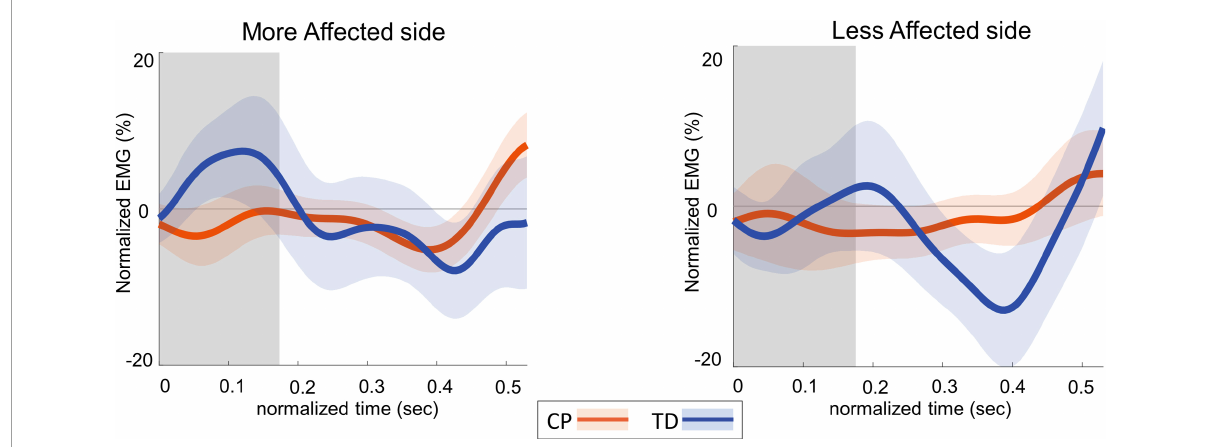
FIGURE6 Group average trajectories for peroneal EMG during the first post-stimulus step following a visual fall perturbation in CP (orange) and TD (blue). Thick gray line along zero at X -axis indicates the mean of control (no fall stimulus) steps, which is subtracted from stimulus data. Shaded areas around each trajectory represent 95% confidence interval. X -axis shows 8 steps, time-normalized to 100 timepoints per steps, with double-stance (gray shading) and single-stance (no shading). Y -axis indicates EMG data normalized to average EMG of no perturbation